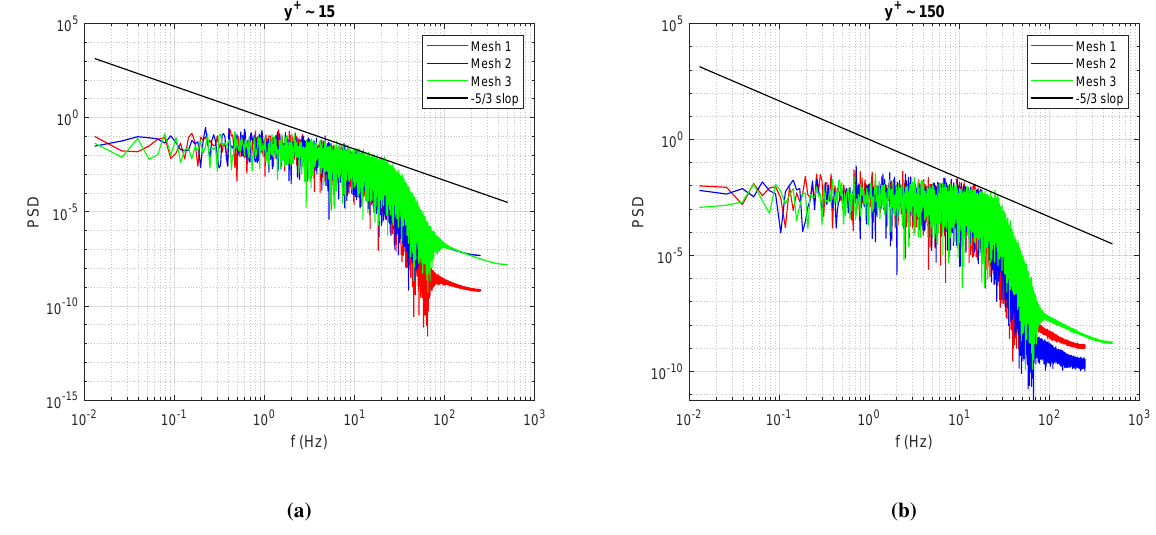
Figure 6: Energy spectra at two y + values Figure 6. Energy spectra at two y + values of ( a ) 15 and ( b )